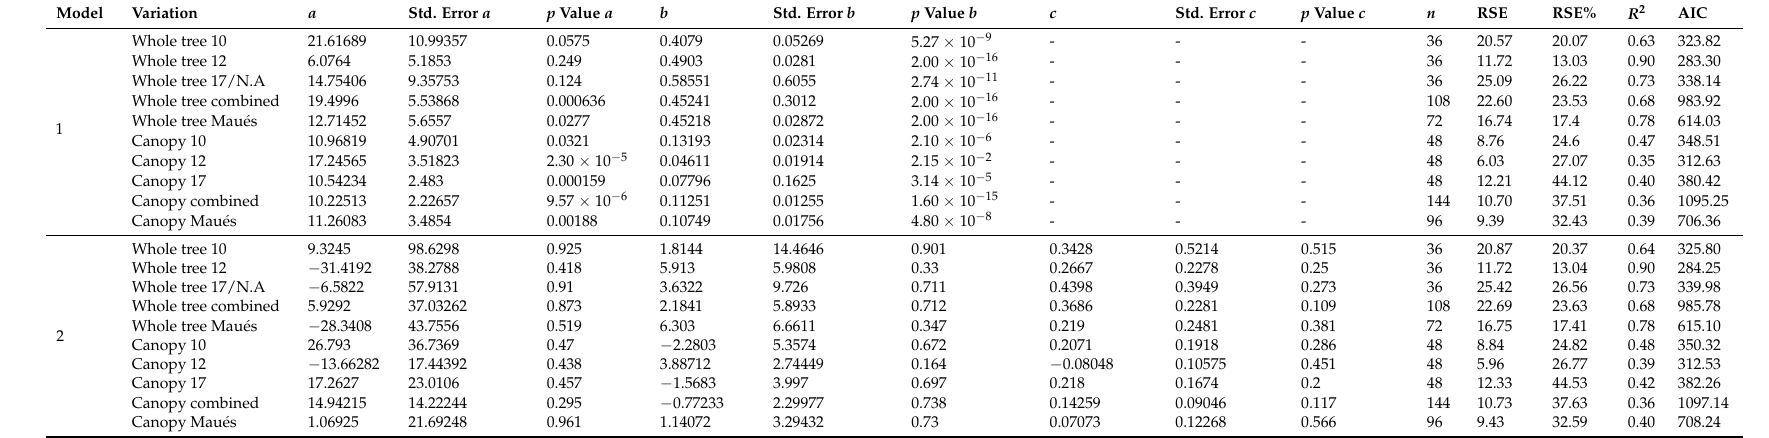
Table A4. Description of test results for the five models tested for tree fresh mass calculation for each category containing parameters calculated for each equation ( a , b , and c ); Significance of the coefficients (p value); standard error of the coefficients (std error.); Number of sample trees used to calculate equation ( n ); Residuals (RSE and RSE%), Coefficient of determination ( R 2 ) and Akaike index (AIC). N.A. means Novo Aripuan ã